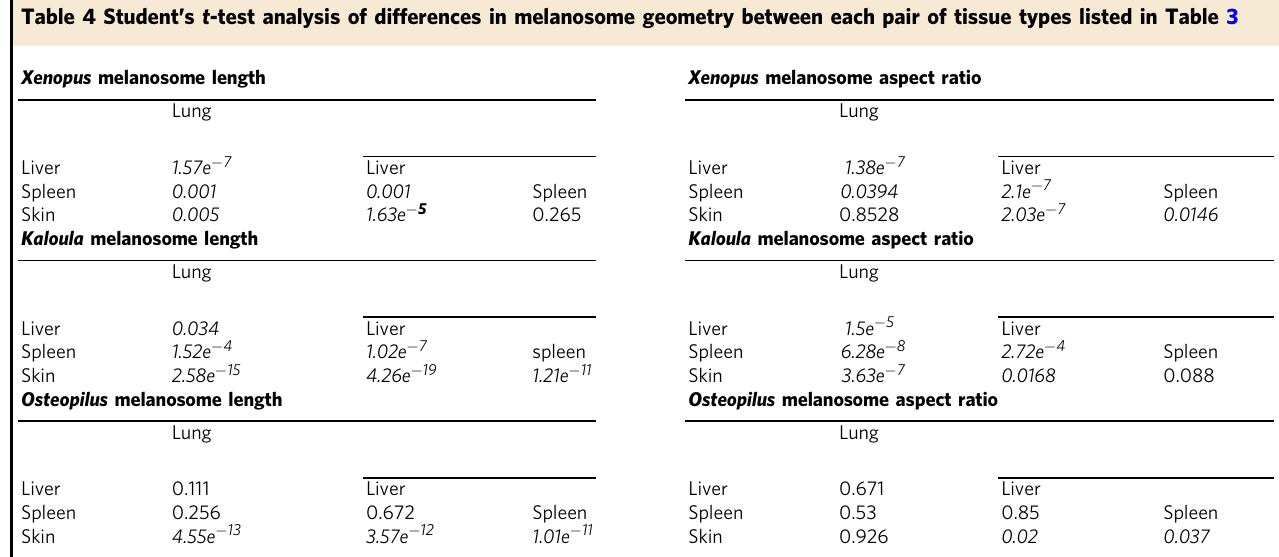
Table 4 Student ’ s t -test analysis of differences in melanosome geometry between each pair of tissue types listed in Table 3